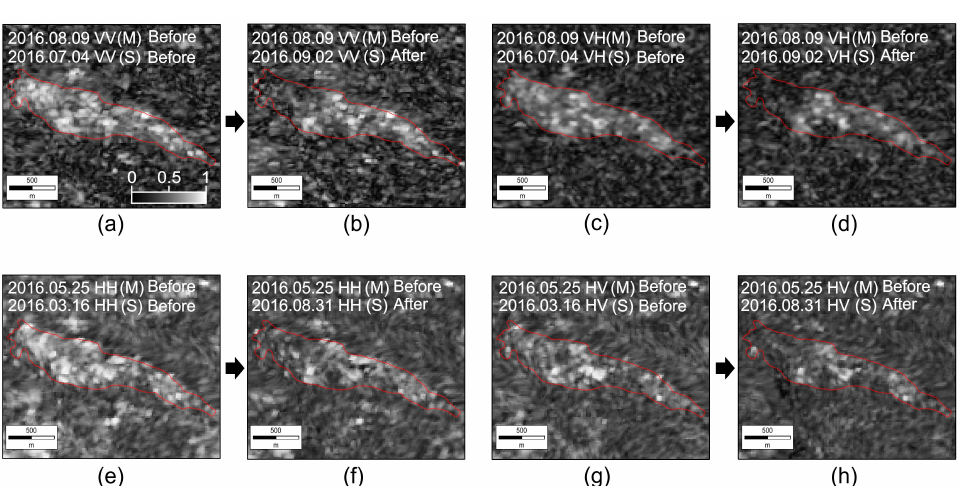
Figure 5. Pre-event and co-seismic coherence ( γ ) of Sentinel-1 data ( a – d ); and ALOS-2 data ( e – h ) in the target area.